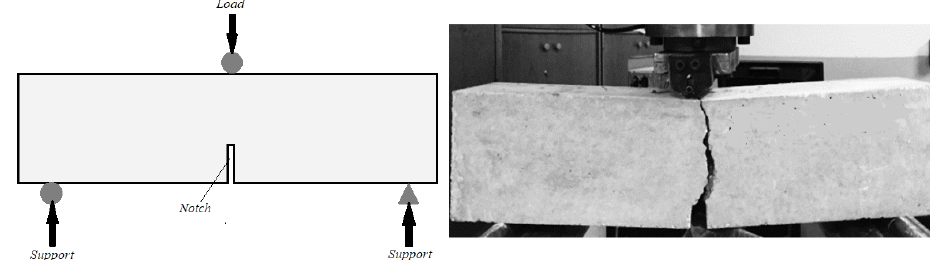
11 of 26 Figure 10. Fracture energy test arrangement. 𝜎 (cid:3404) 3 𝐹𝐿 / (cid:4666) 2 𝑏ℎ (cid:2870) (cid:4667)